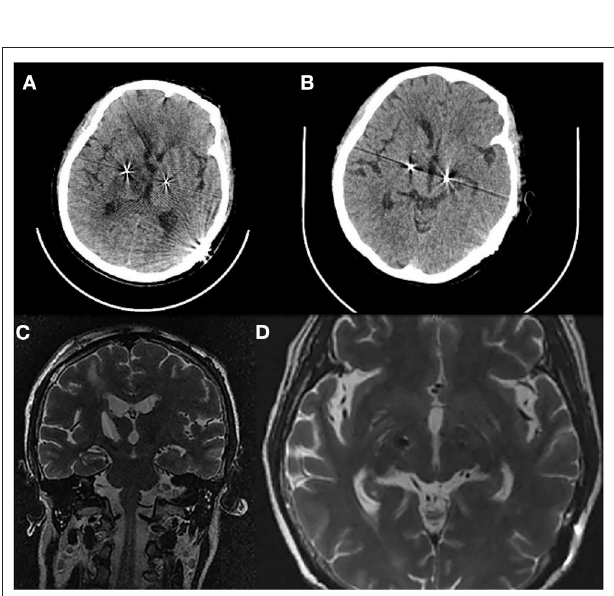
FIGURE 3 | (A) Axial CT 1 day after cyst aspiration demonstrates the cyst that have almost disappeared. (B) Axial CT 6 days after cyst aspiration. (C)